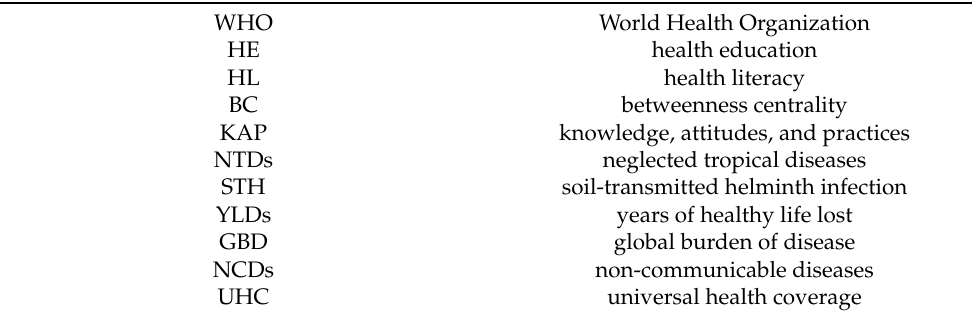
Table 1. Glossary of